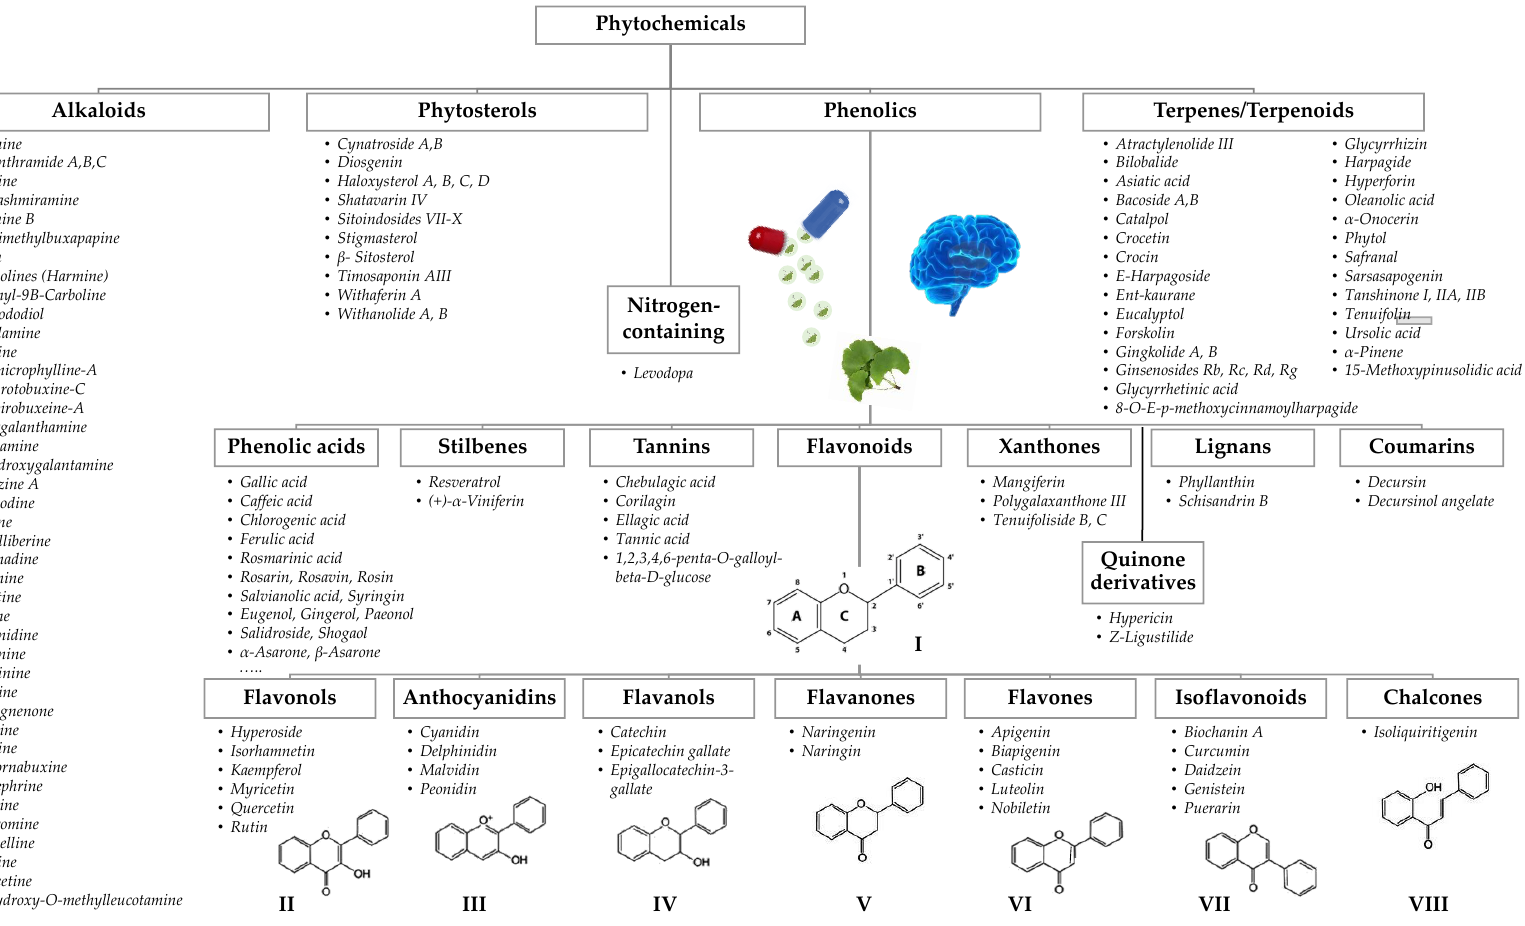
Figure 3. Classification of phytochemicals found in botanicals used in cognitive enhancement. For clarity, compounds, which due to the reduced expression were grouped as “others”, are not represented; in a similar fashion, a shortened list of phenolic acids and only the aglycone part of flavonoids are shown. The structural backbone of flavonoids ( I ) comprises two phenyl rings ( A , B ) and a heterocyclic ring ( C ); the flavonoid family is classified into different groups, such as flavonols ( II ), anthocyanidins ( III ), flavanols ( IV ), flavanones ( V ), flavones ( VI ), isoflavonoids ( VII ), and chalcones ( VIII ), according to the degree of oxidation and substituent